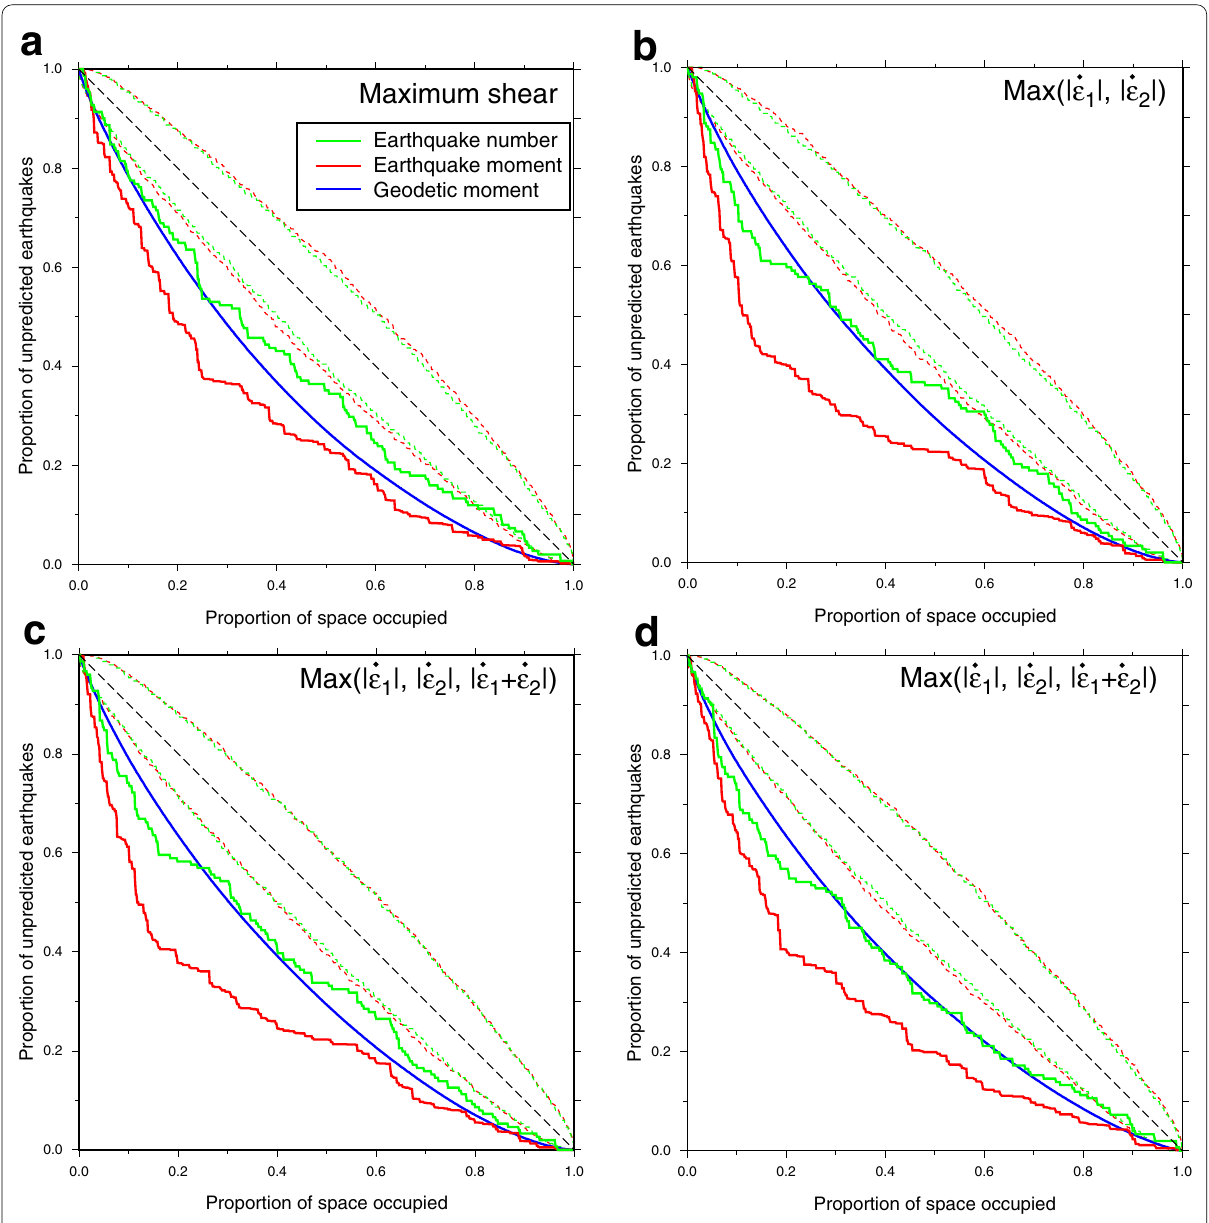
Fig. 5 Comparison of cumulative moment/number between GNSS strain rates and all M 6 earthquakes (599–2020). Horizontal axis is the grid ≥ number in descending order of GNSS strain rates. Blue, red, and green lines indicate normalized moments converted from GNSS strain rates, normalized moments for all earthquakes, and the number of all earthquakes, respectively. Broken green and red lines indicate 95% confidence intervals of the non-correlation model. The moment and number are cumulative values from the first cell (e.g., the highest strain rate) to the corresponding cell, respectively. a VARI1 model, b VARI2 model, c VARI3 model, and d UNI3